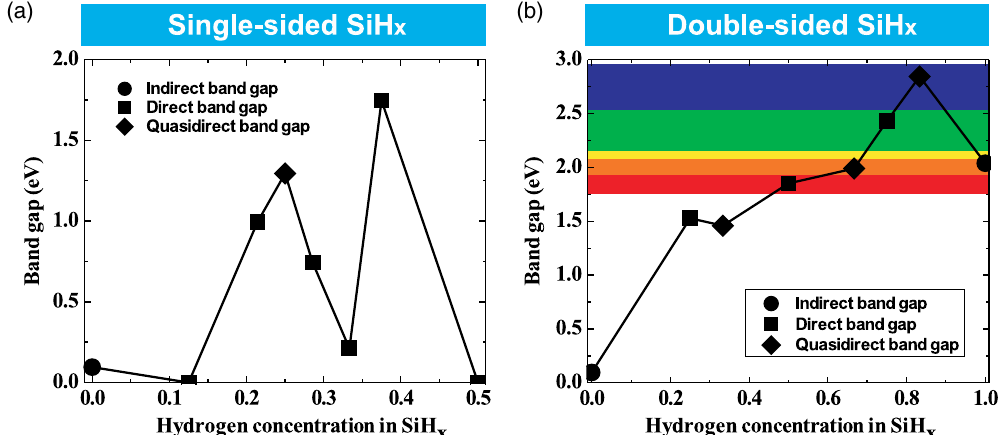
FIG. 5. The calculated band gaps of (a) single-sided SiH concentration. In panel (b), a sketch of light spectrum is overlaid to aid visualization of the size of band gap.